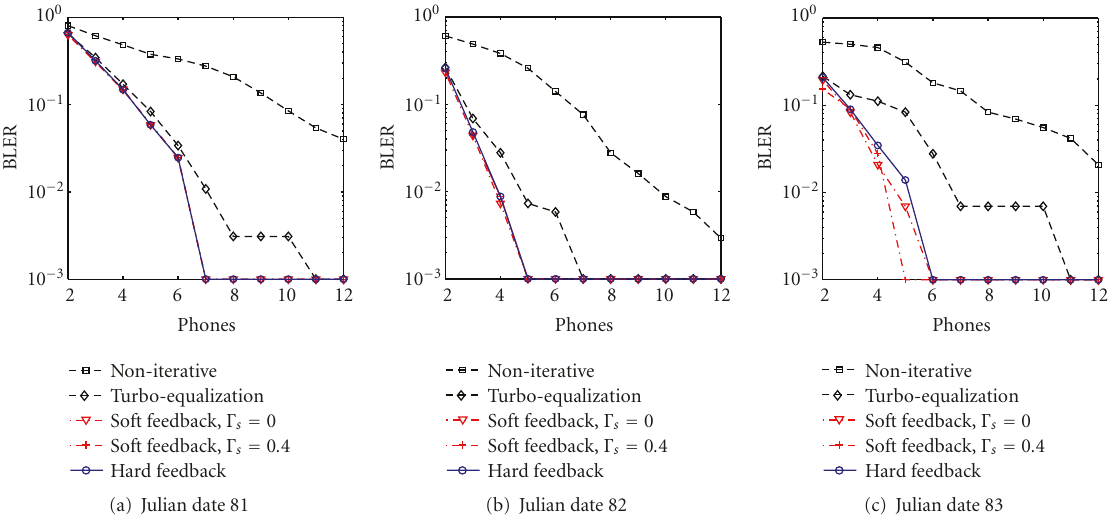
Figure 7: Experimental results from the RACE08 experiment on MIMO-OFDM with N t = 2 and 16-QAM.